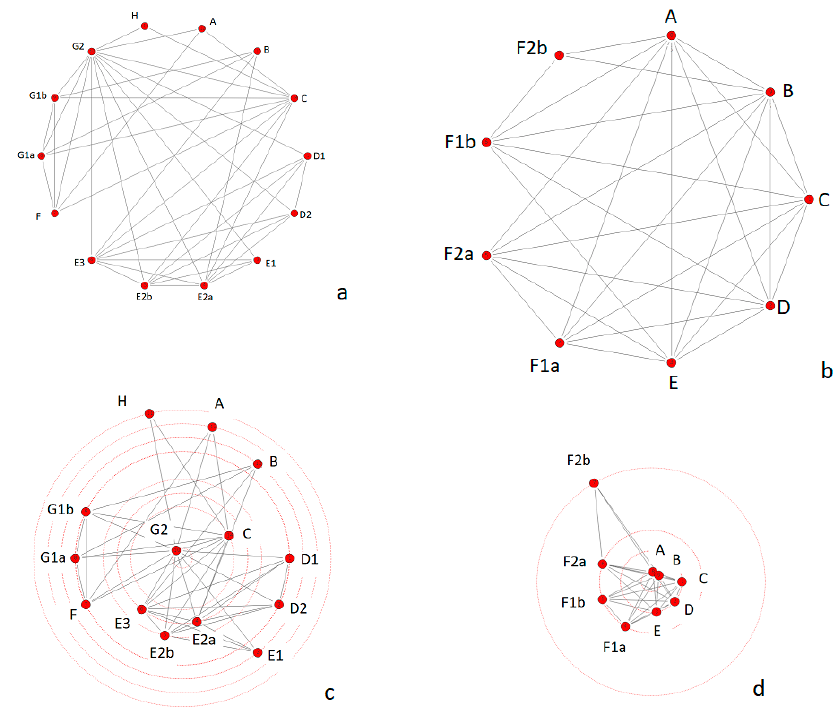
Figure 7. Agreements among concepts for Q 1 ( a ) and Q 2 ( b ) and radial representations of the respective networks showing the central concepts in each case (( c ) for Q 1 and ( d ) for Q 2 ) for all participants (all age groups).